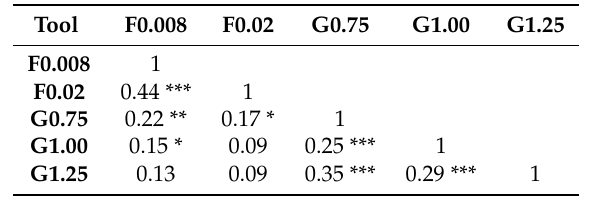
Table 5. Spearman’s correlation coefficients between tools in the total samples of the subjects ( n =